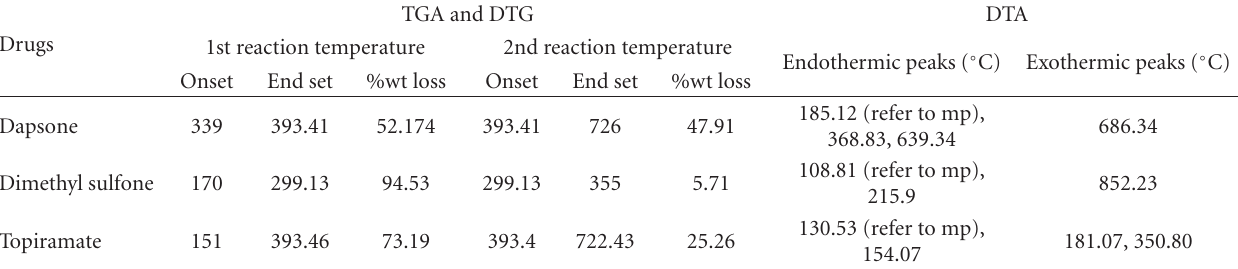
Table 1: Thermal decomposition data of TGA, DTG, and DTA curves of Dapsone, dimethyl sulfone, and